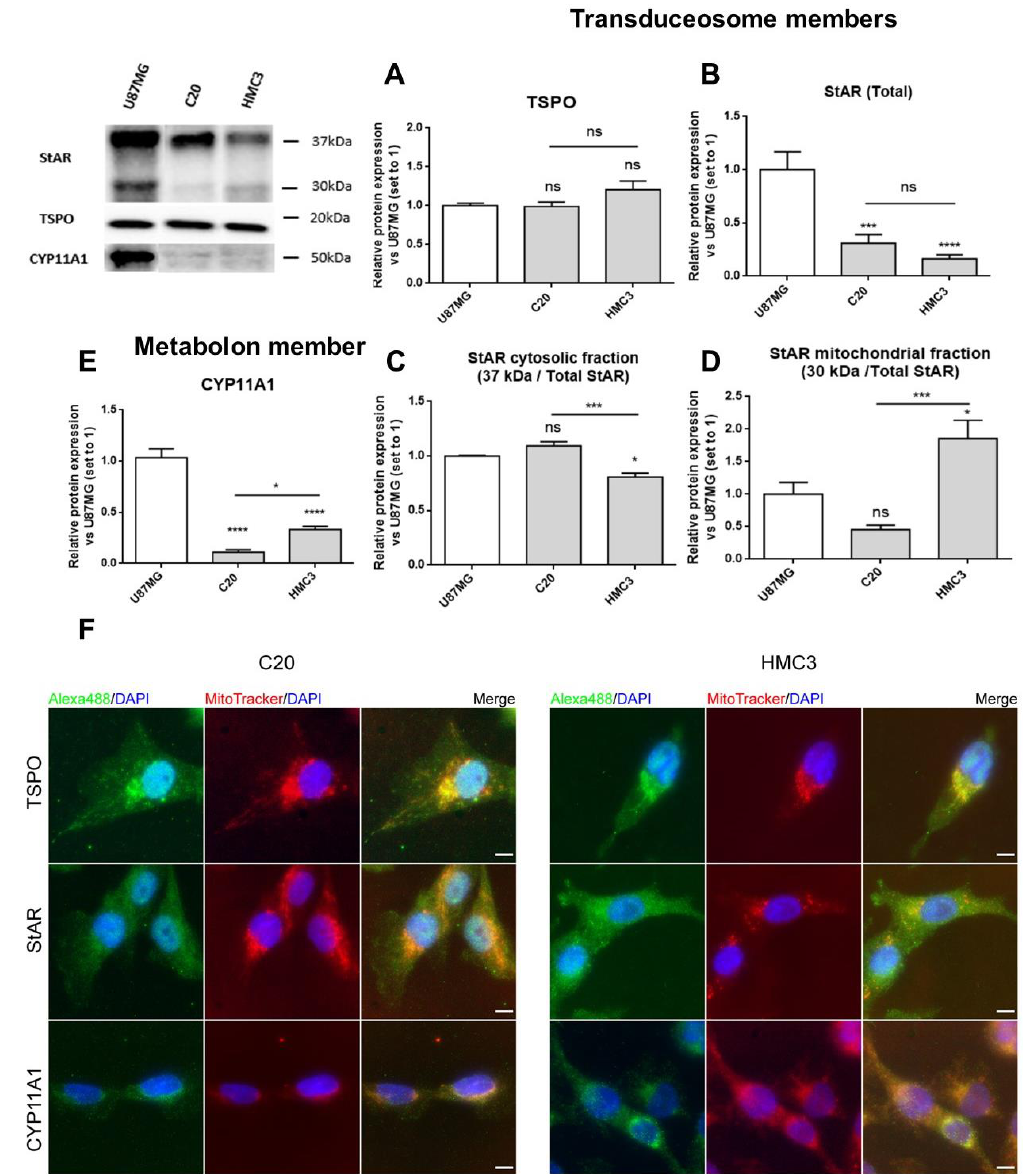
Figure 2. Expression of transduceosome/metabolon key proteins for neurosteroidogenesis in C20 and HMC3 cells. A representative Western blot panel for the expression of transduceosome members StAR and TSPO and the metabolon member CYP11A1 is reported. As shown in the panel, C20 and HMC3 cells expressed all transduceosome and metabolon members in basal conditions. ( A – E ) Densitometric analysis showed high expression of TSPO in both microglial cells ( A ), but StAR ( B ) and CYP11A1 ( E ) were expressed at lower levels if compared to the known neurosteroidogenic representative model (U87MG cells). Interestingly, the StAR cytosolic fraction ( C ) was reduced in HMC3 cells with respect to C20 cells. Moreover, the StAR mitochondrial fraction ( D ) and CYP11A1 in HMC3 cells seemed to be more expressed in comparison to C20 cells. Such differences could be due to the different developmental stages of the two microglial clones. Data are represented as means ± SEMs of three independent experiments. Statistical analysis was determined by one-way ANOVA followed by Bonferroni’s post-test: * p < 0.05, *** p < 0.001, **** p < 0.0001. ( F ) The expression of the transduceosome/metabolon members was also qualitatively evaluated with immunofluorescence analysis, which confirmed the Western blot results. The panel reports representative images of the co-localization study between TSPO, StAR, and CYP11A1 (green) with mitochondria stained with MitoTracker dye (red). DAPI staining is overlaid on both images to highlight cell nuclei. Scale bar: 10 µ